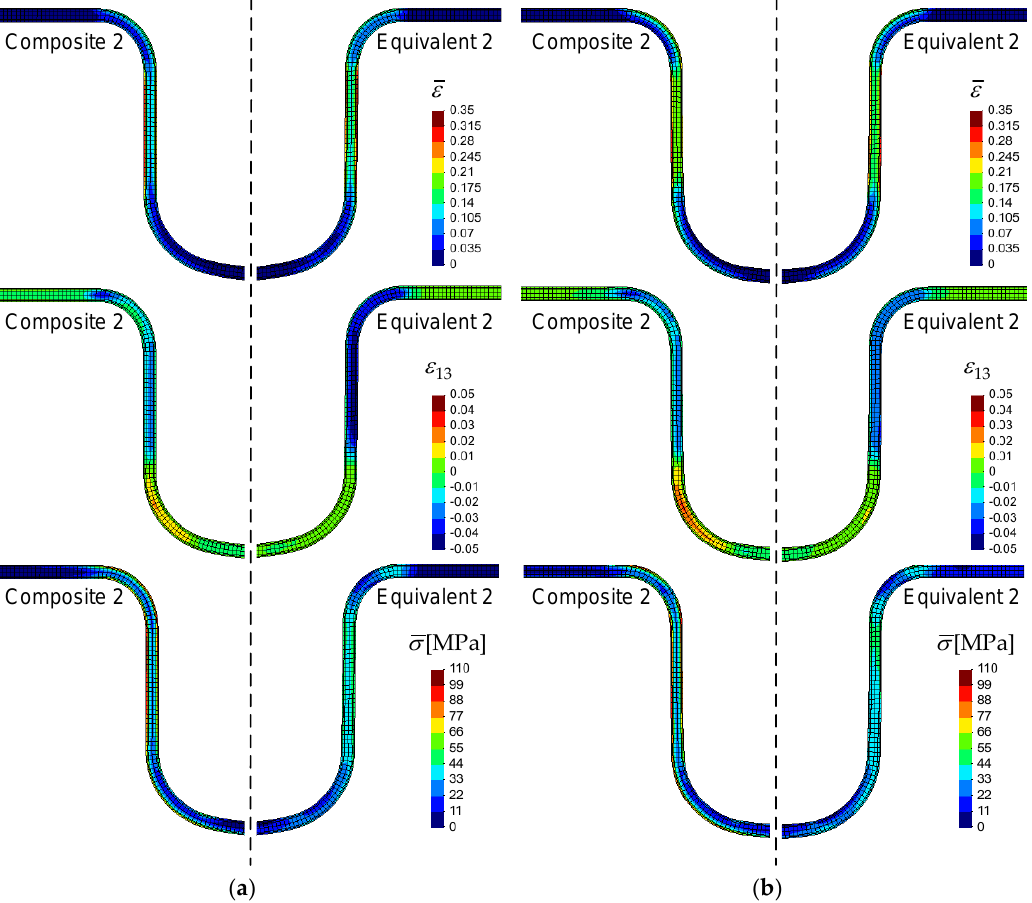
Figure 12. Distributions of equivalent plastic strain, 𝜀̅ , Green–Lagrange shear strain, 𝜀 13 , and equivalent stress, 𝜎 , for Composite 2 and the equivalent material: ( a ) Case A; ( b ) Case B. The maximum values of 𝜀̅ , 𝜀 13 and 𝜎̅ are, respectively: 0.302, 0.02 and 103.86 MPa (for Composite 2 in Case A); 0.318, 0.032 and 105.52 MPa (for Composite 2 in Case B); 0.341, 0.01 and 53.86 MPa (for Equivalent 2 in Case A); 0.337, 0.01 and 53.53 MPa (for Equivalent 2 in Case B).